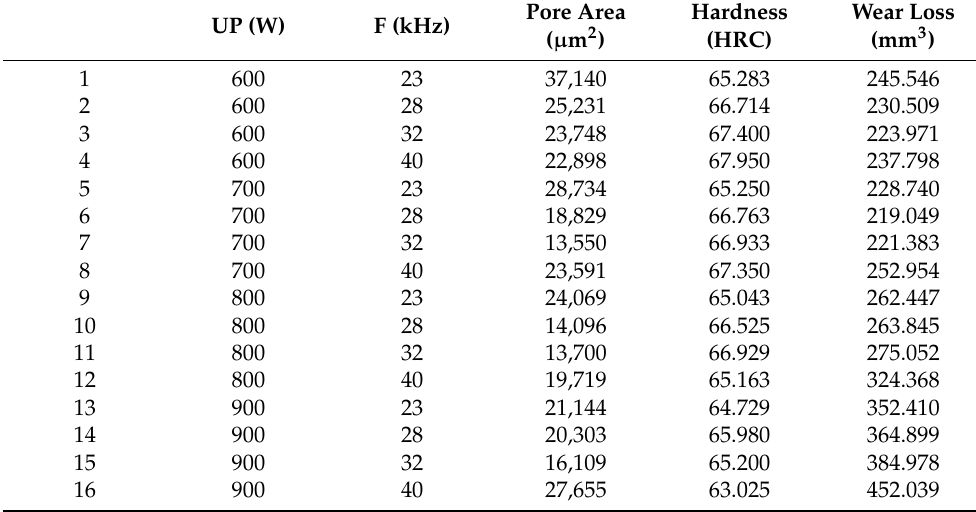
Table 3. Test factors and Table 2. Experimental factors and levels.